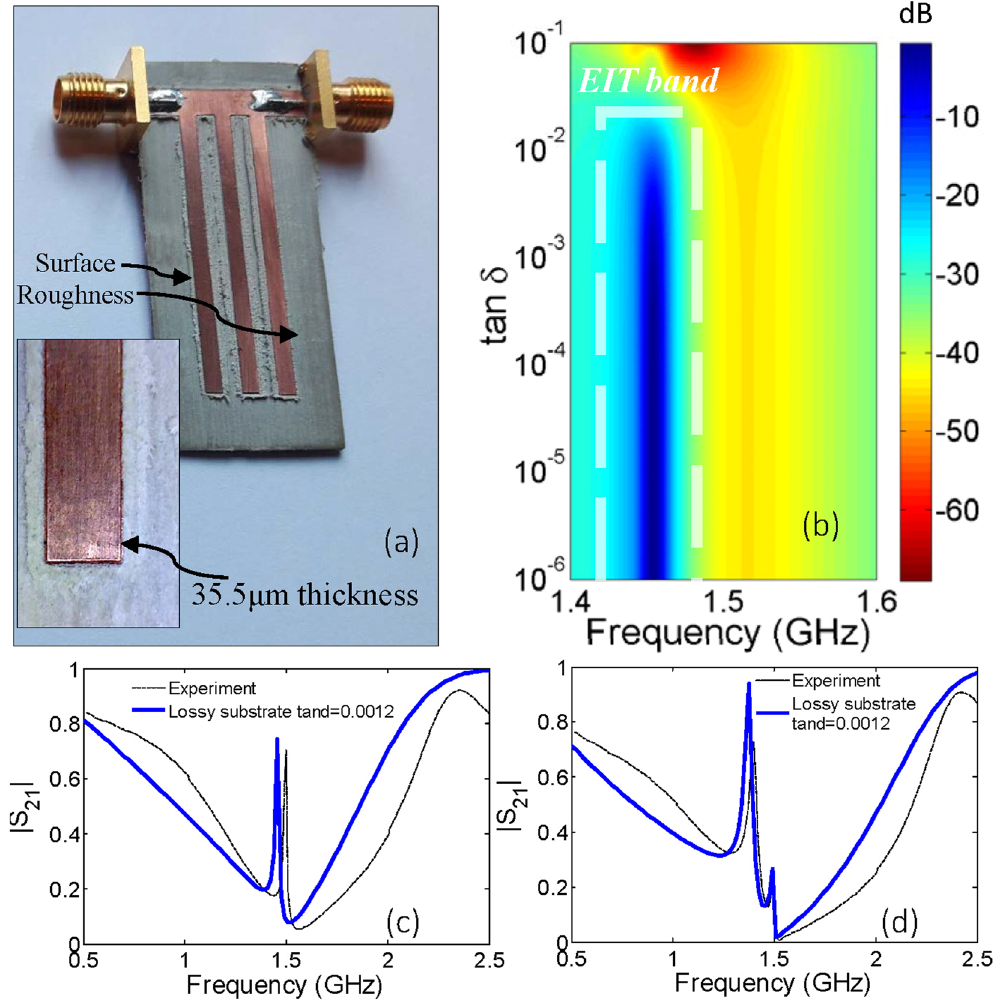
Figure 4. ( a ) Surface roughness of microstrip lines causes unpredictable losses in experiments. ( b ) Simulated results for S 21 as a result of variation in substrate losses (tan δ ) for double open-stub resonator. It is found that at a loss tangent of 0.0012 leads to an additional losses in the EIT band for the ( c ) the double stub and ( d ) triple stub